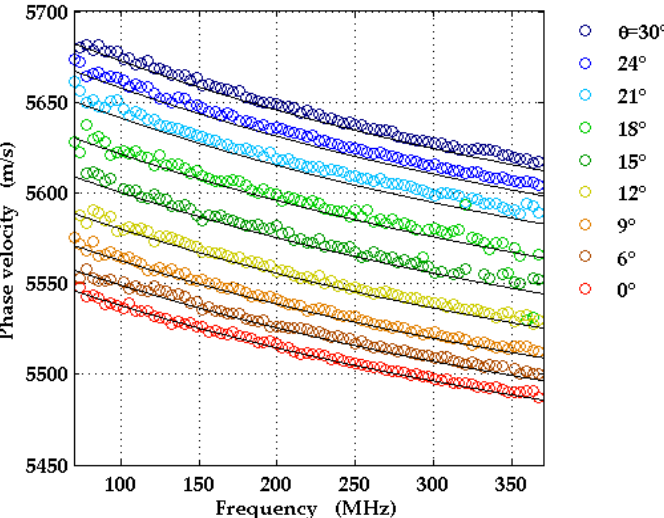
Figure 9. Experimental and theoretical dispersion curves for the different directions θ for Ti/Al 0.77 Sc 0.23 N(0001)/Al 2 O 3 (0001). In the calculations, the elastic constants from [30] for sapphire and material constants from [5] for AlScN were used.